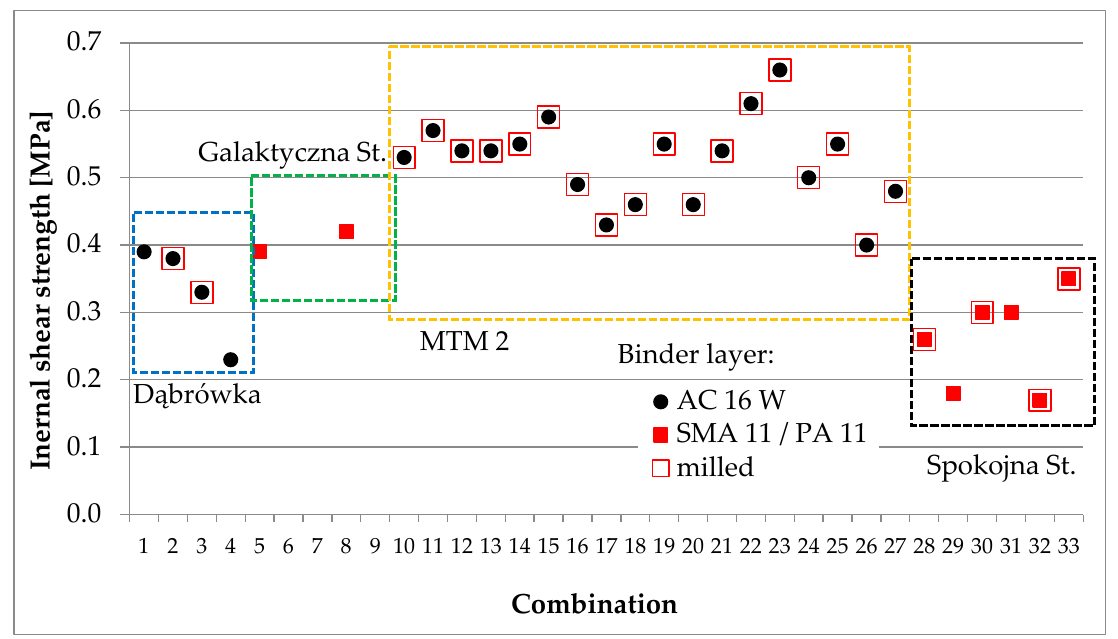
Figure 14. Summary of internal shear strength results for samples from test sections.